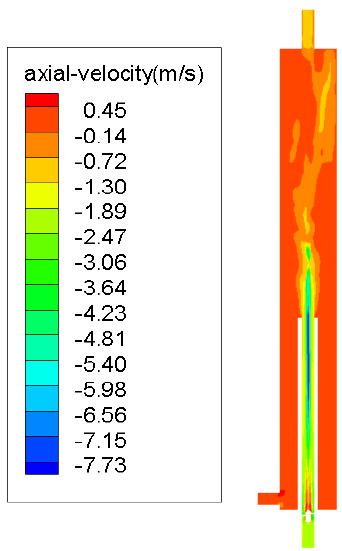
Figure 11. Internal axial velocity distribution of the separator.